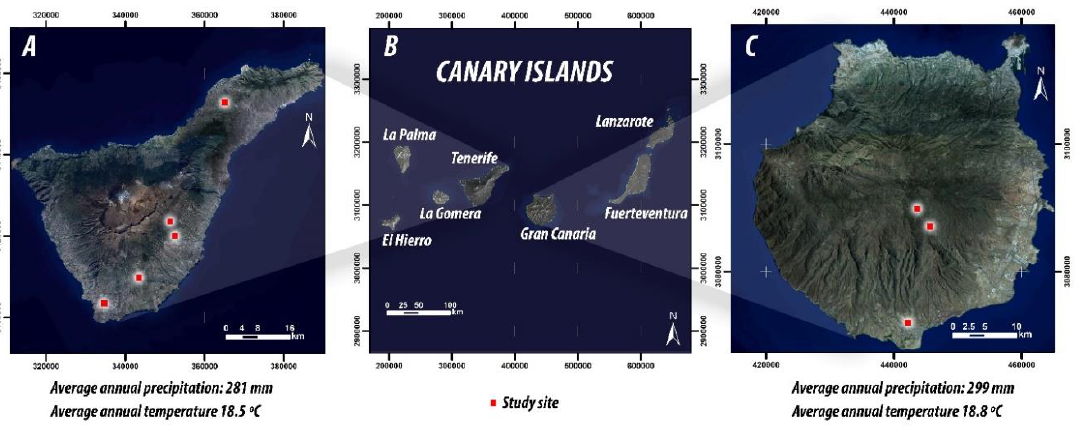
Figure 2. Map of the Canary Islands ( B ) with the location of the facilities studied in Tenerife ( A ) and Gran Canaria ( C ).